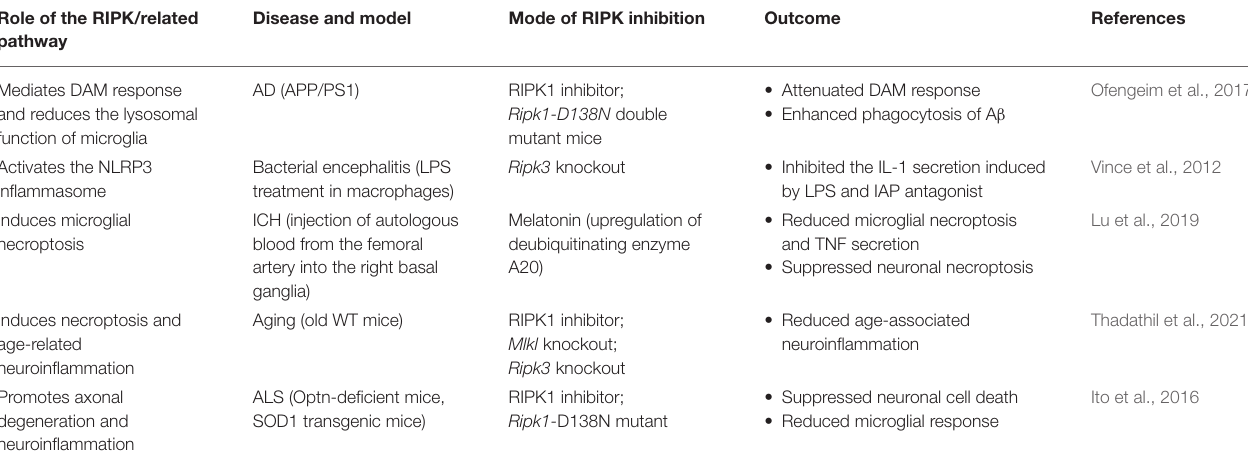
TABLE 1 | Pharmacological and genetic interventions that manage cell death and inflammation in RIPK-related pathways in CNS diseases. Role of the RIPK/related